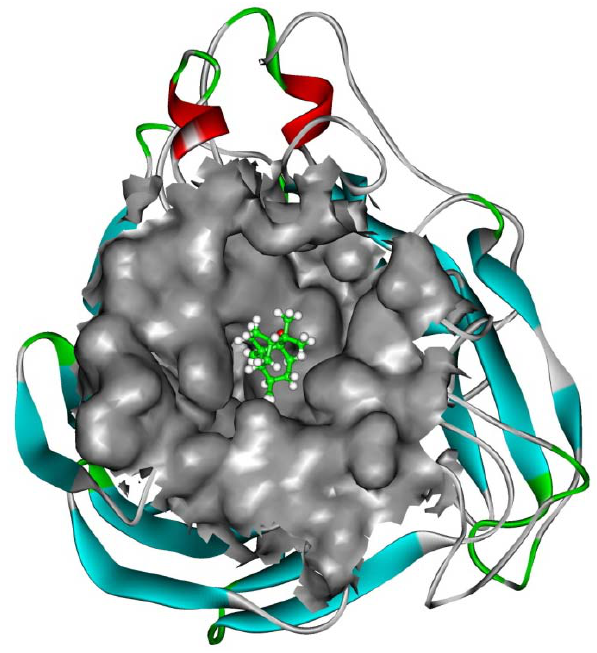
Figure 4. Patchouli alcohol bound at the NA active site. The Connolly surfaces of the NA active site (in grey) are created using the InsightII 2005 scripts. The patchouli alcohol is represented by ball and stick model. Ribbon colors: Helices, beta sheets, turns and random coils are in red, cyan, green and white,